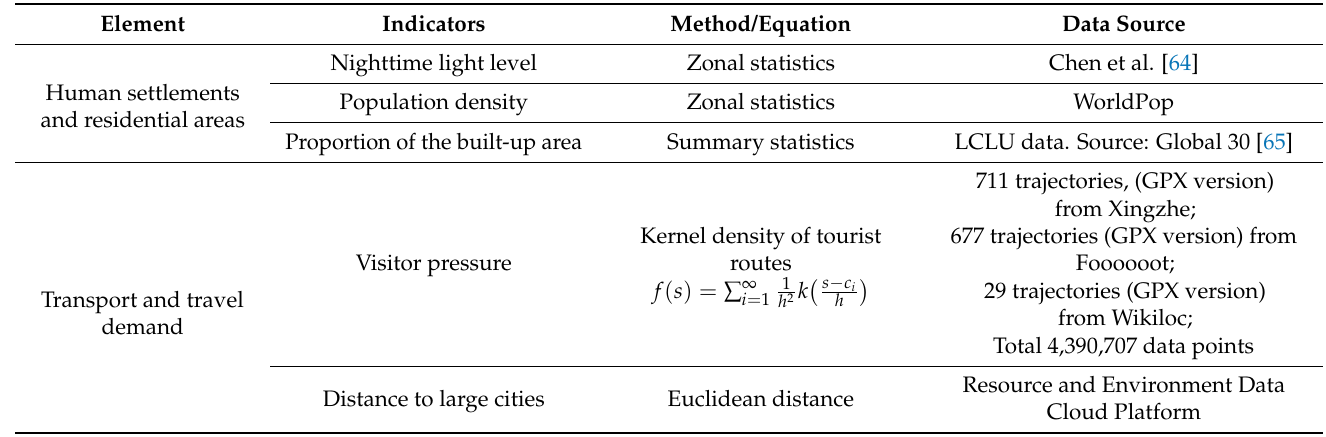
Table 2. The data source and calculation methods of indicators used in the